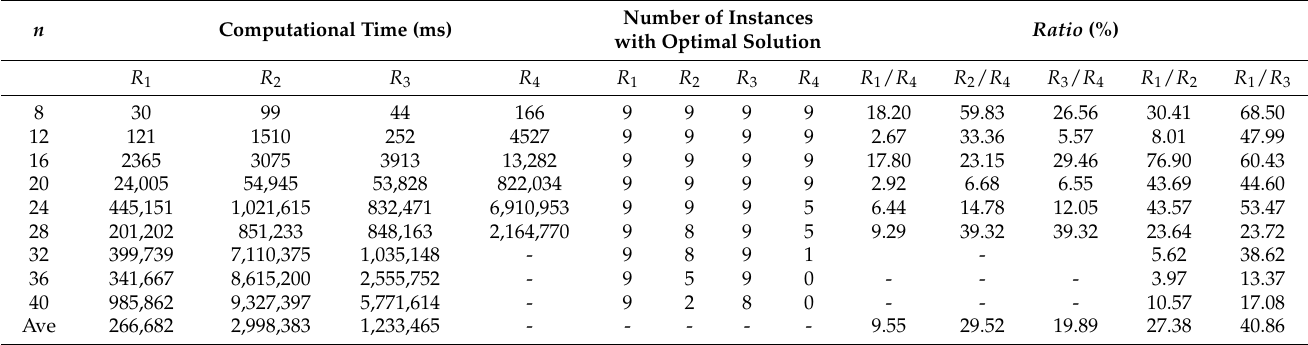
Table 4. Comparison results of different acceleration